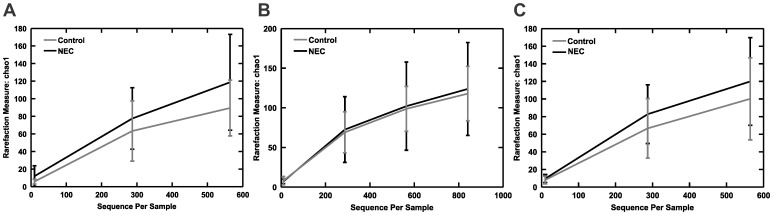
Chao rarefaction diversity.Chao diversity was calculated from the OTU distribution A) 2 weeks before diagnosis of NEC; B) 1 week before diagnosis of NEC; and C) Week of diagnosis of NEC. As a measure of beta (within sample) diversity it is an estimate of the expected total number of OTUs detected in the sample if sequenced to completion.